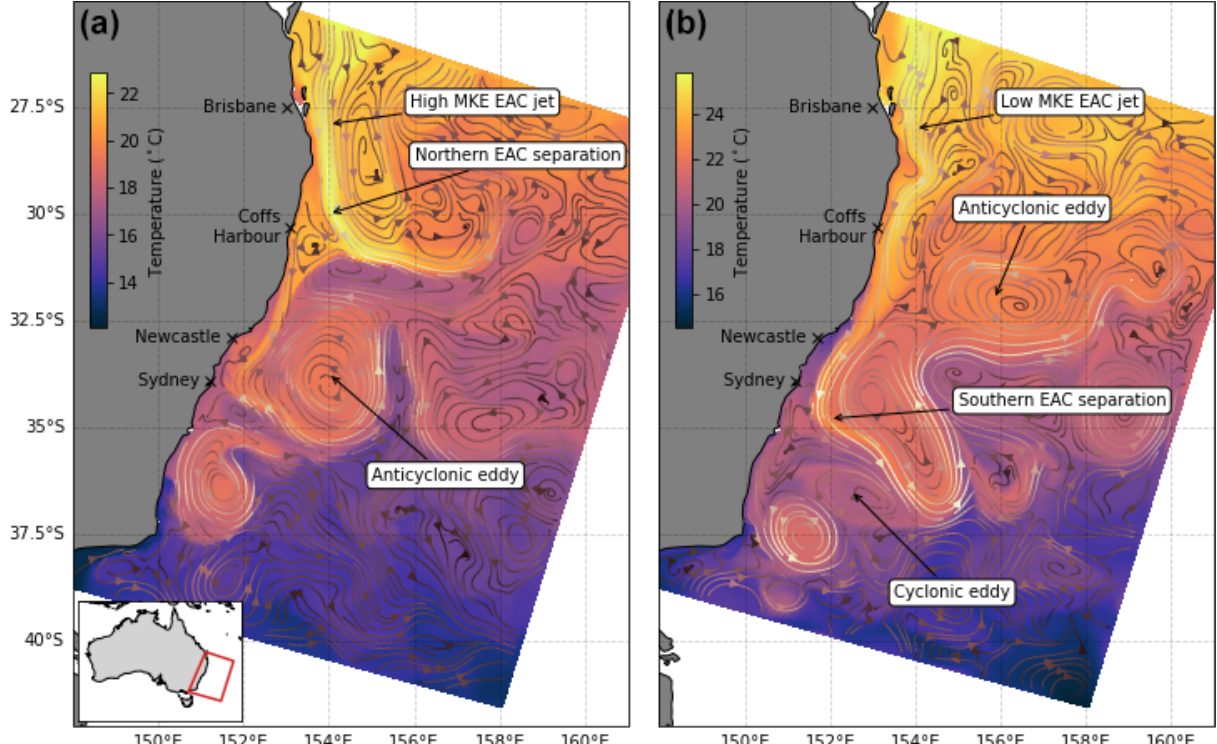
Figure 1. Flow regimes of the EAC, highlighted in snapshots of sea surface temperature (colour) and circulation (arrows). The EAC flows southwards past Brisbane, generally as a coherent jet, before separating from the coast between Sydney and Coffs Harbour. (a) A higher mean kinetic energy of the EAC jet generally leads to more northern EAC separation, while (b) a lower mean kinetic energy in the EAC jet generally leads to more southern EAC separation (Li et al., 2021a). Flow instability leads to the generation of cyclonic and anticyclonic eddies. The background is coloured for model sea surface temperature and the streamlines indicate the concurrent surface circulation. Inset in (a) shows model domain in red